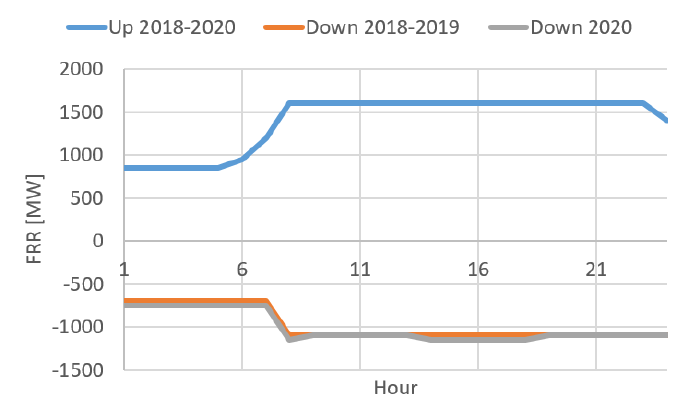
Figure 1. Representative reserve sizing values for upward/downward capacity in the Greek electric- ity market in